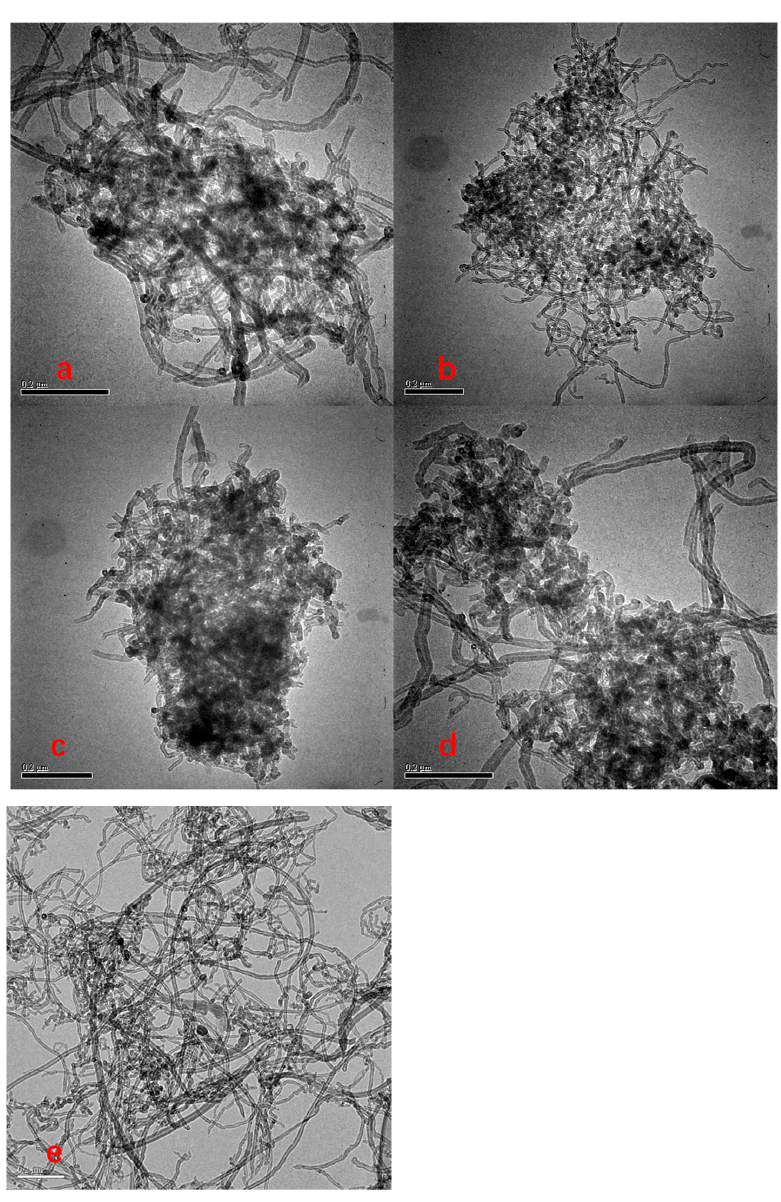
Figure 4. TEM of MWCNTs on TW-80 interacting with MWCNTs ( a , b ), TX-100 interacting with MWCNTs ( c , d ), and MWCNTs ( e ). MWCNTs ( c , d ), and MWCNTs ( e